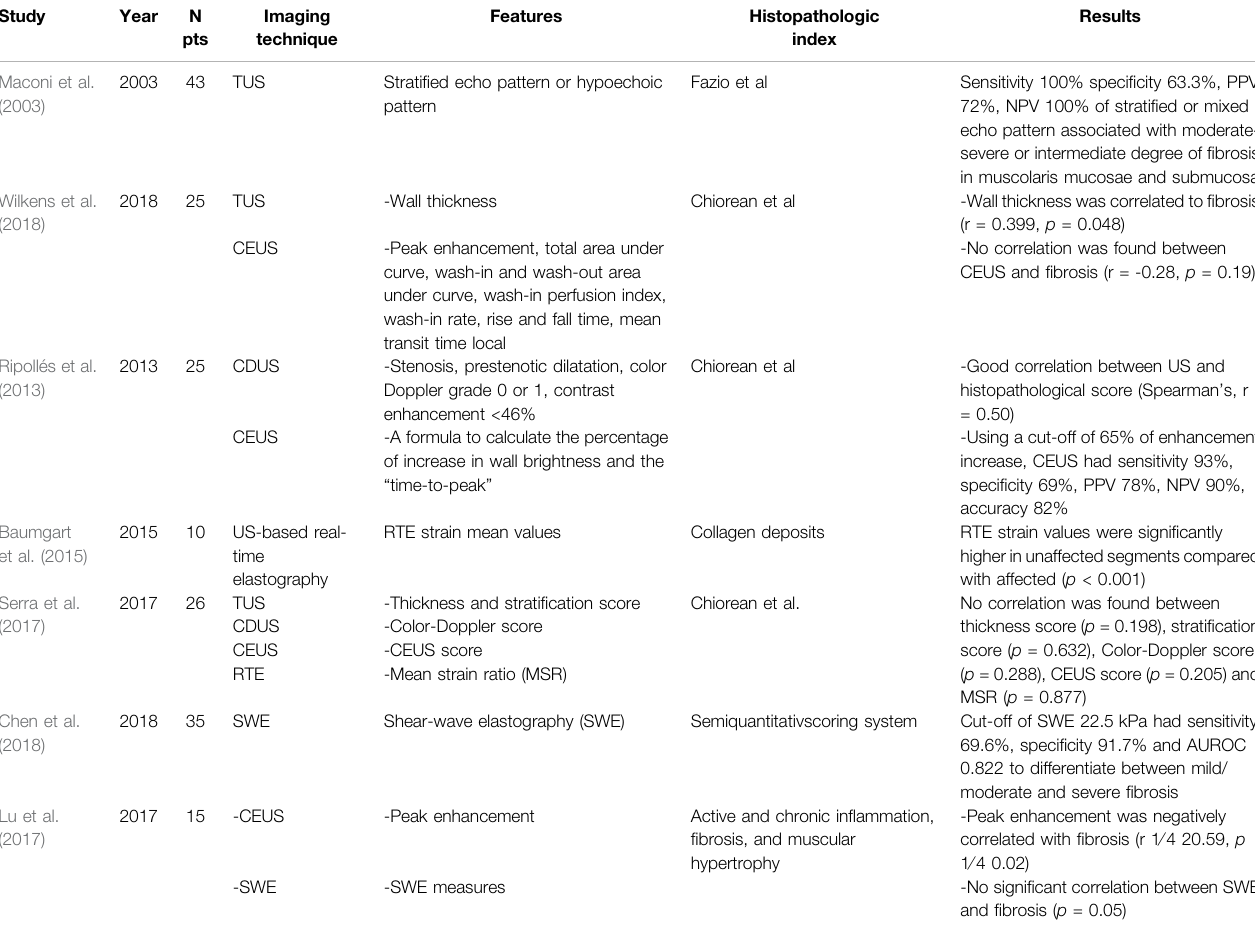
TABLE 2 | Imaging techniques and characterization of the fi brotic stricture compared with histology.